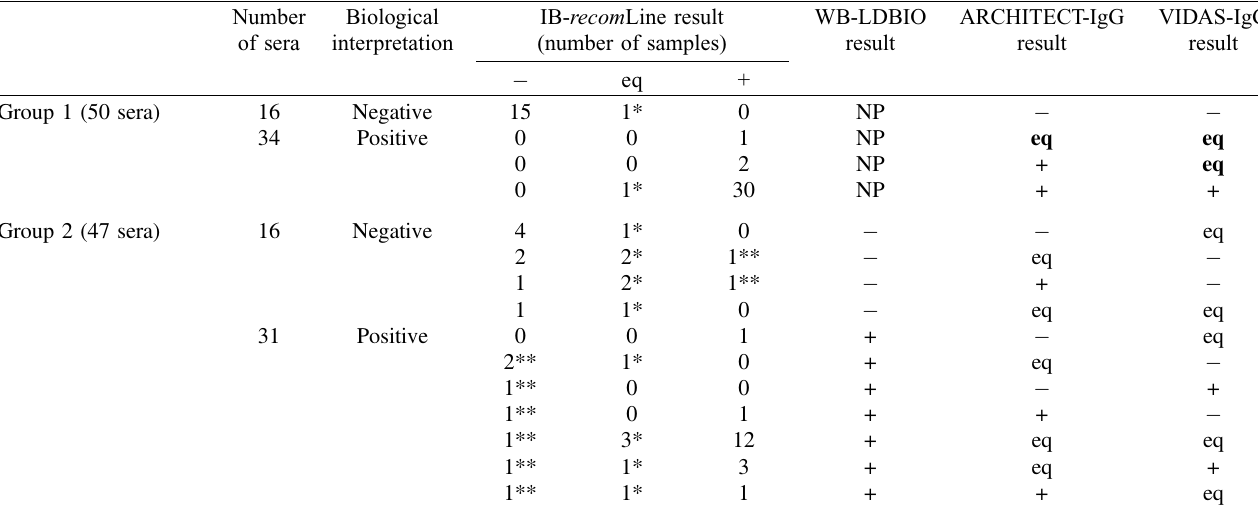
Table 1. IB- recom Line IgG results of the 97 characterized sera of groups 1 and